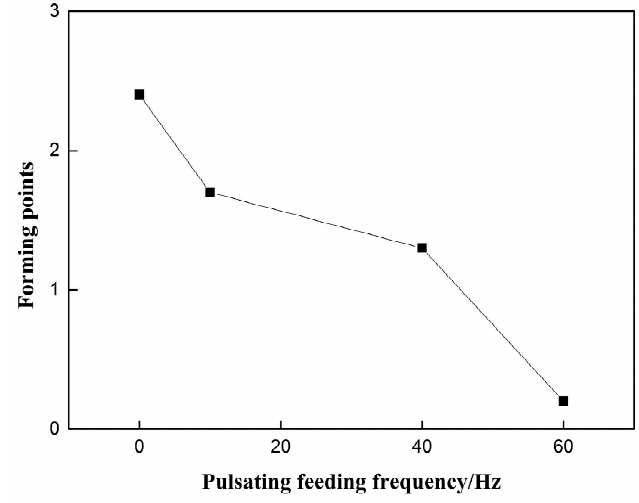
Figure 6. Effect of pulsating feeding frequency on weld forming.